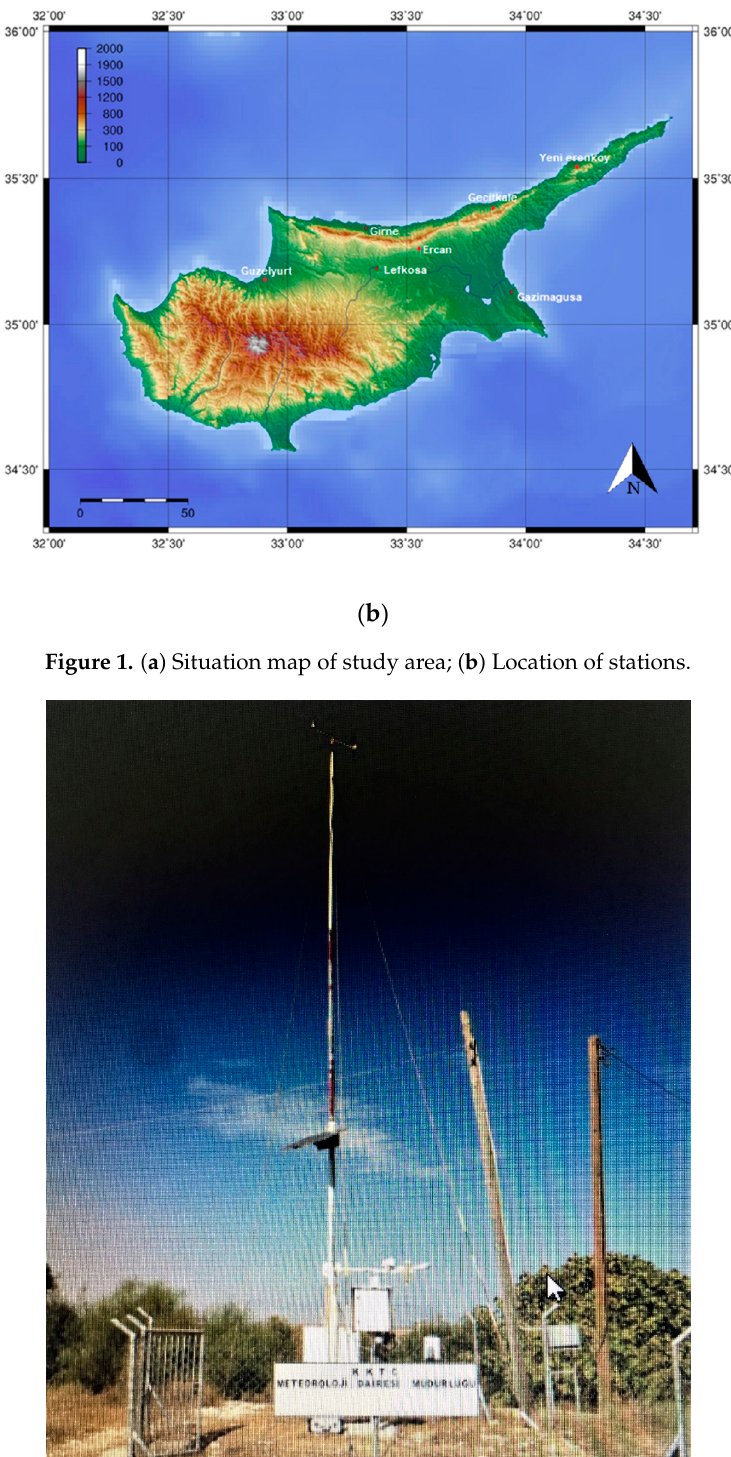
( b ) Figure 2. ( a ) Lefkosa rain gauge station; ( b ) Rain gauge with the installation equipment. The following numbers refer to the installation equipment of rain gauge (see Figure 2 ( b )): 1 = Sensor base; 2 = Sensor cable; 3 = Outer tube; 4 = Stand; 5 = Mounting bolts for the stand; 6 = Wedge bolts; 7 = Nut and washers for mounting bolts.